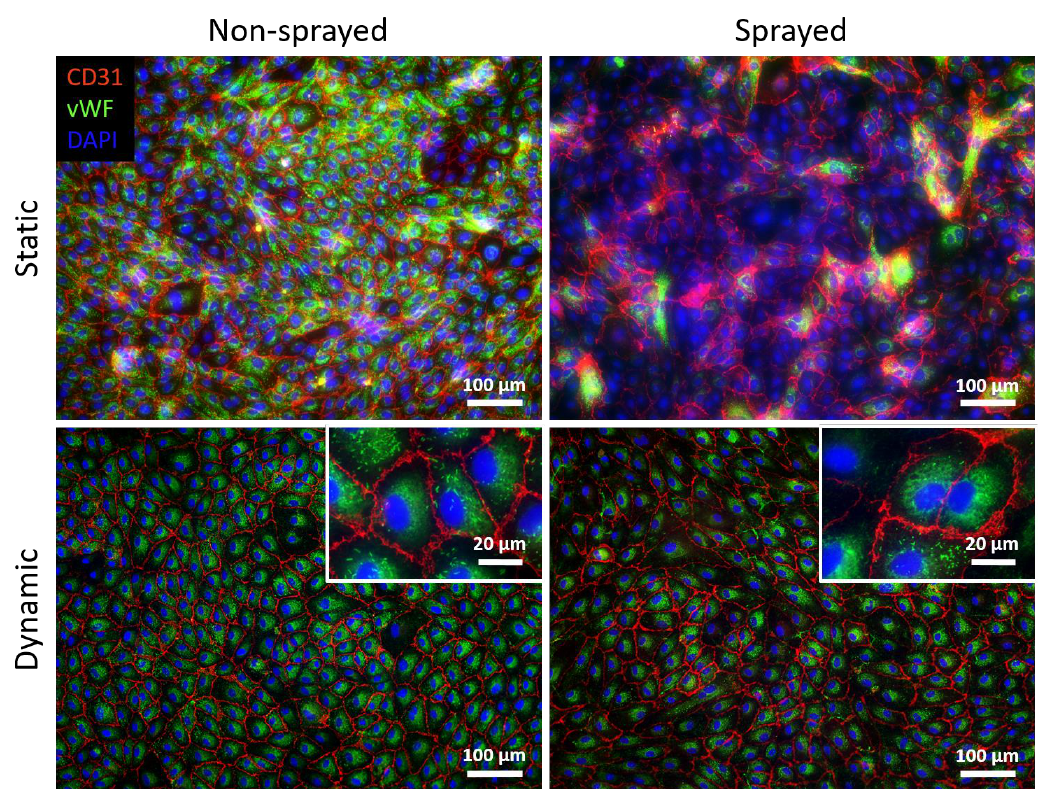
Figure 6. Immunocytochemical staining of non-sprayed and sprayed HUVECs after static and dynamic cultivation with WSS of 5 dyn/cm 2 against CD31 (red) and von Willebrand factor (vWF, green). DAPI (blue)-stained cell nuclei. Representative pictures are shown.